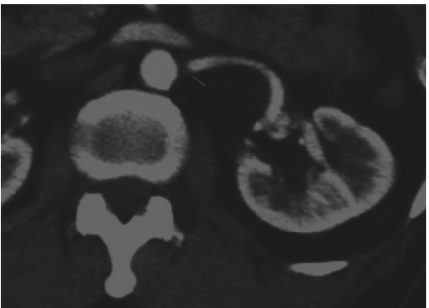
Figure 1: CT scan reveals retroperitoneal lipoma around the left renal pedicle, 30mm in diameter, causing a curving of the left renal artery and dilatation of the left renal vein.